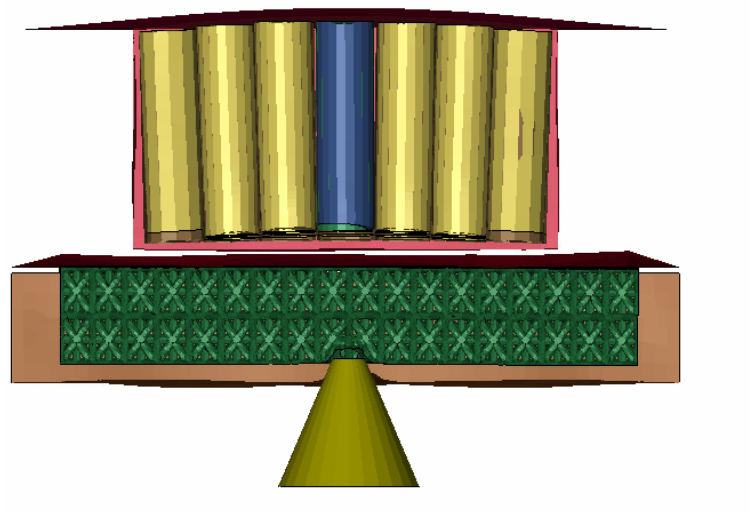
Figure 19. Battery Protection System Response to Ground Impact.